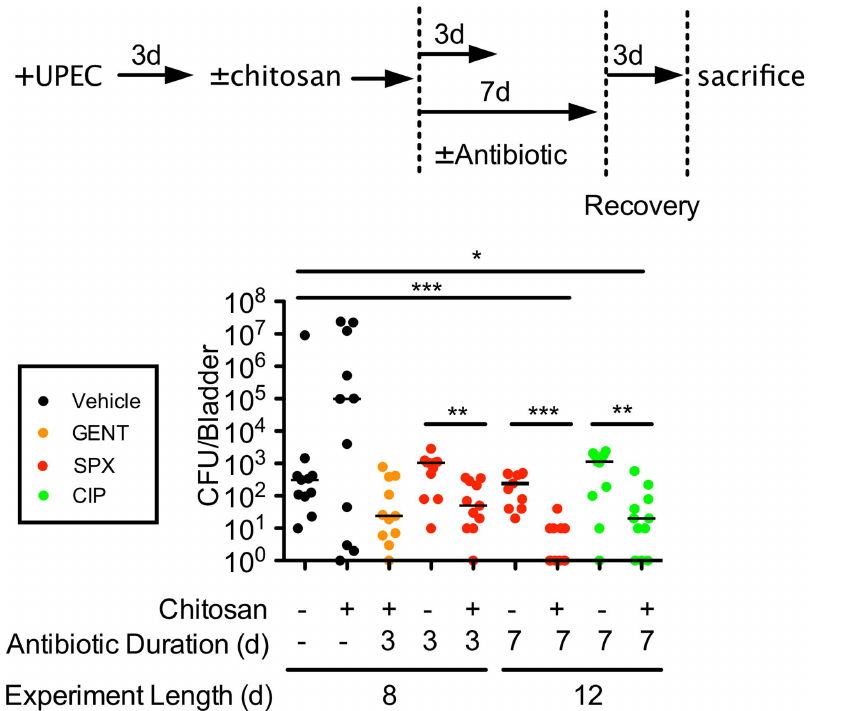
Figure 4. Chitosan treatment enhances the efficacy of antibiotics in reducing bacterial titers within the bladder. Mice were infected with UTI89 via transurethral catheterization 3 d prior to instillation of phosphate buffer alone or 0.01% chitosan. After a 20-min incubation and subsequent washes with PBS, mice were treated for 3 or 7 d with gentamicin (GENT), sparfloxacin (SPX), or ciprofloxacin (CIP), as indicated. Mice were sacrificed 3 d after cessation of antibiotics or mock treatments. An outline of the experimental setup is shown on top. Bars in the graph indicate median values for each sample group; n=11 mice total from two independent assays. * P , 0.02, ** P , 0.005, *** P # 0.0002; as determined by Mann- Whitney